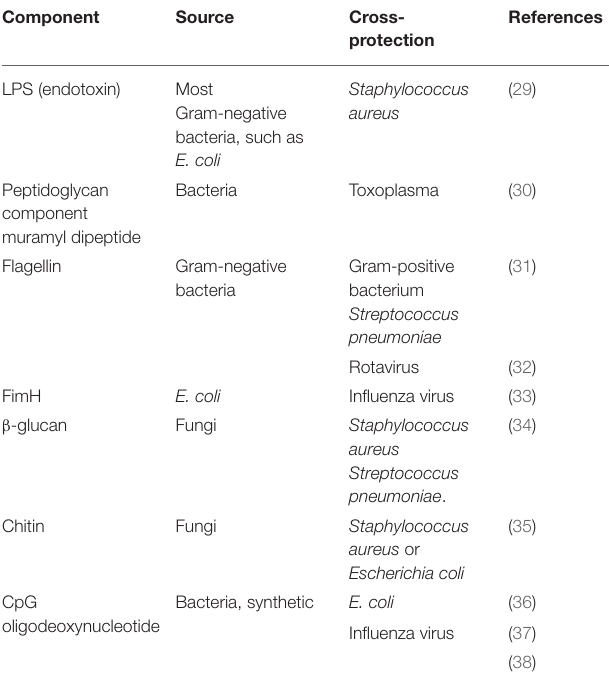
TABLE 2 | Examples of pathogen-associated molecules with experimental evidence of cross-protection.